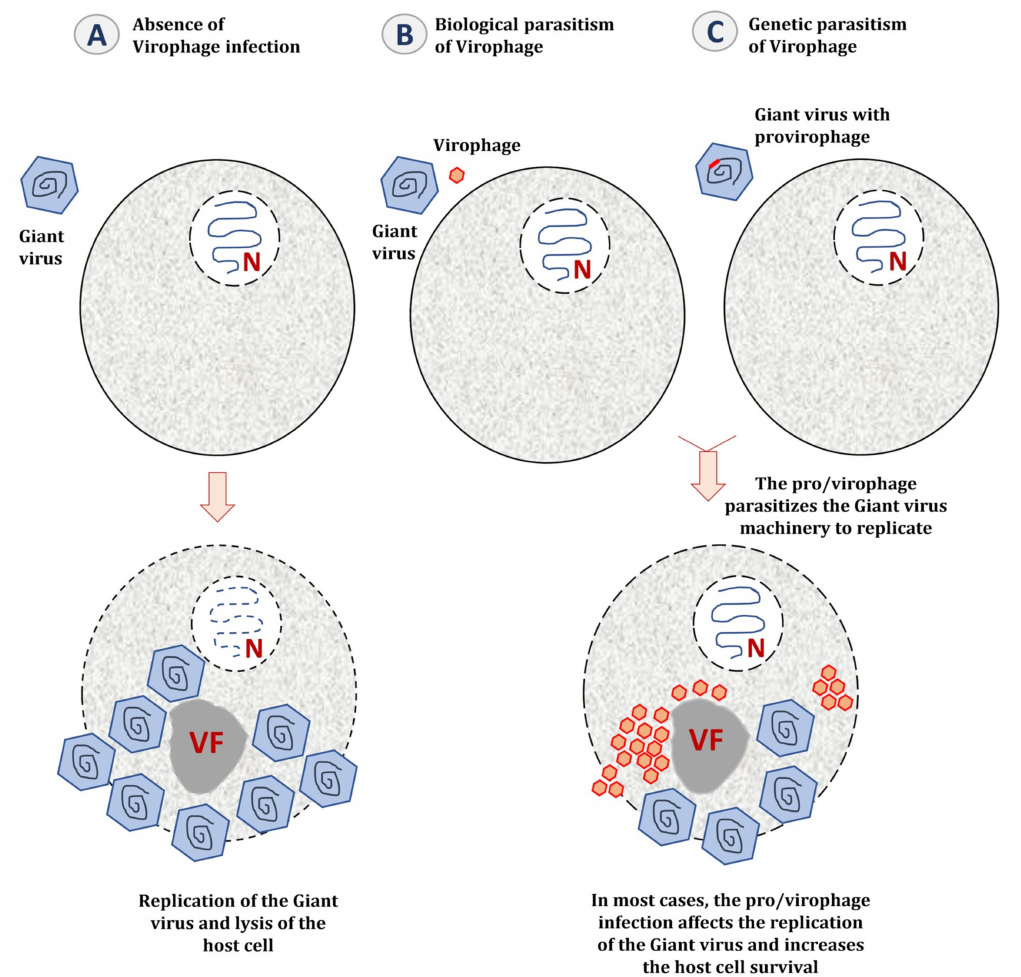
Figure 4. The parasitic lifestyle of virophages. ( A ) When the host cell is only infected by a giant virus, the latter establishes a cytoplasmic virus factory to replicate and generates new virions, and the host cell is most likely lysed at the end of its replication cycle. ( B ) When the host cell is co-infected with a giant virus and its virophage, the latter parasitizes the giant virus factory. The presence of virophages could seriously impact the infectivity of the giant virus by decreasing its replication e ffi ciency and increasing the survival of the host cell. ( C ) When the giant virus genome is parasitized by a provirophage, the latter is expressed during the giant virus replication. The virophage is produced from the giant virus factory and inhibits the giant virus replication, thus increasing the host cell survival. VF: Virus